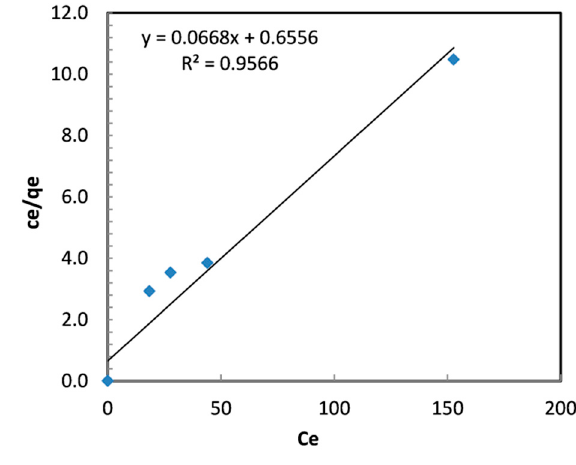
Figure 10. Langmuir isotherm plots for the removal of Cr (VI) by TBC-P. Table 4. Isotherm model parameters.